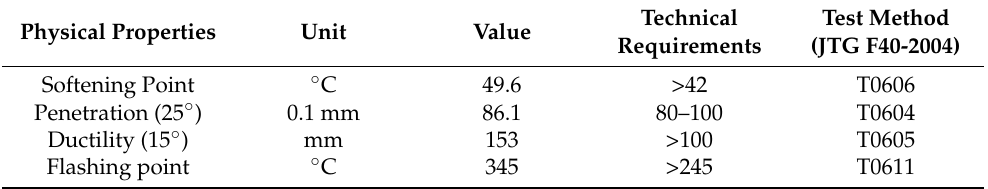
Table 3. Physical properties of 90# matrix